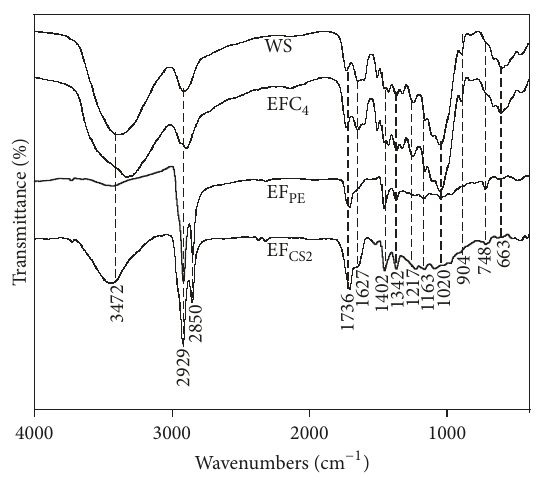
Figure 1: FTIR analysis of WS, EFC 4 , EF PE , and EF CS 2